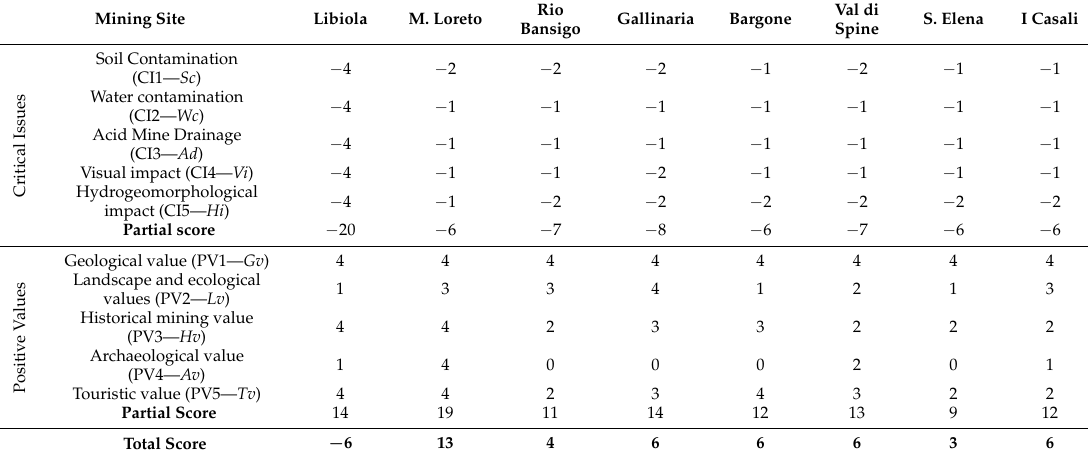
Table 3. Total and partial scores for the eight mines studied based on the descriptors of the flowchart of Figure